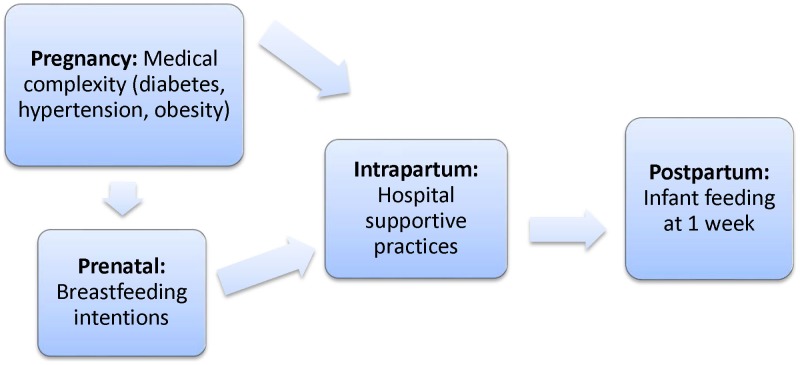
Conceptual Model.